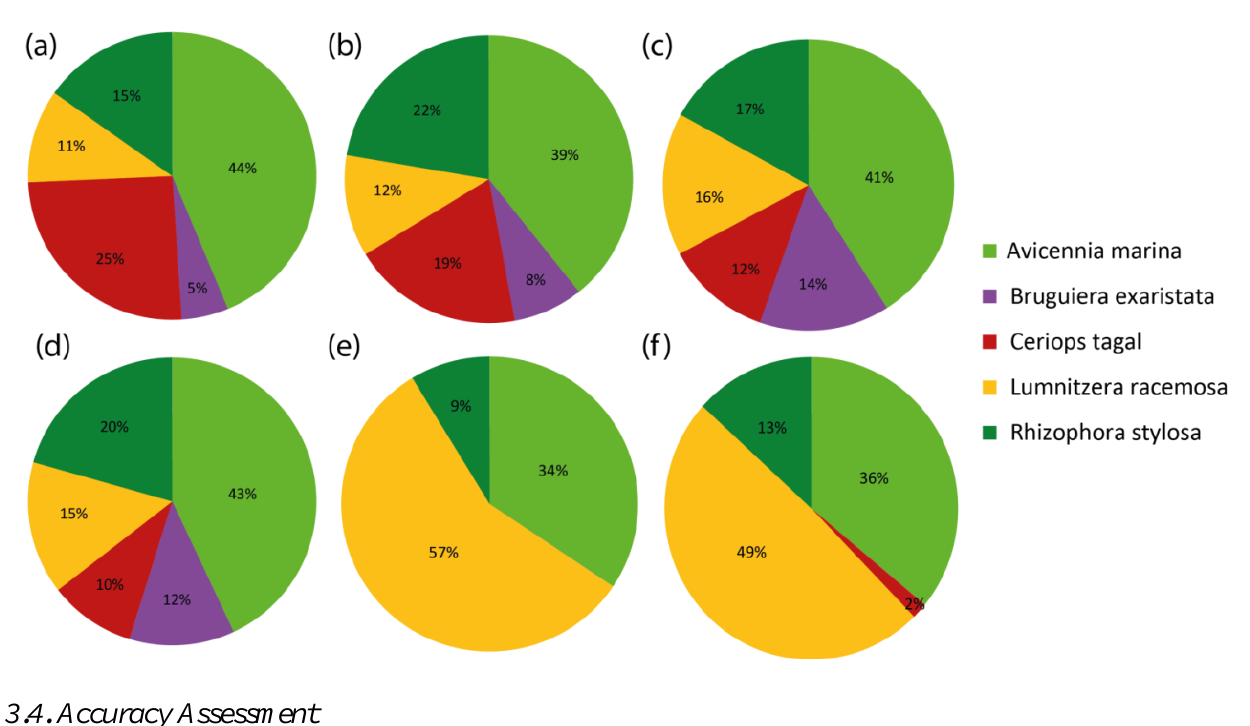
Figure 8. Extents (%) of mangrove species obtained using six different input datasets: ( a ) pan-sharpened WV2 image with bands blue to red-edge; ( b ) pan-sharpened WV2 image with bands red to NIR; ( c ) aerial photographs with 0.14 m spatial resolution; ( d ) aerial photographs with 0.5 m spatial resolution; ( e ) WV2 image with bands blue to red-edge; and ( f ) WV2 image with bands red to